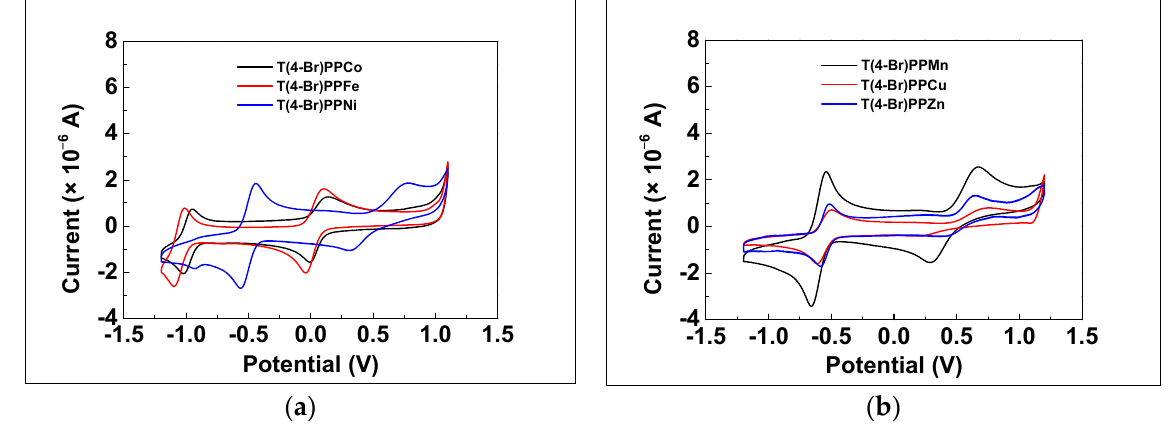
Figure 4. Cyclic voltammetric curves for metalloporphyrins ( a , b ). UV–vis spectroscopy was used to monitor the metalloporphyrin reaction with H 2 O 2 . The spectrum (Figures 5 and S1) initially showed a signal band at 420 nm, but when the experiments were carried out using H 2 O 2 , a new band at 430 nm was found. The active species in the reaction, Fe(III)OOH intermediates, had a characteristic band in the range of 430 nm, and the presence of PorFe(III)OOH was confirmed by ESI-MS, indicating that the radical mechanism was valid. When compared to the reaction of metalloporphyrins iron(II) and H 2 O 2 , the reaction of metalloporphyrins Co(II) and Mn(II) displayed fewer spectrum changes, indicating lower catalytic activity of Co(II) and Mn(II). Metalloporphyrins Cu(II), Zn(II), and Ni(II), showed no spectrum change when exposed to H 2 O 2